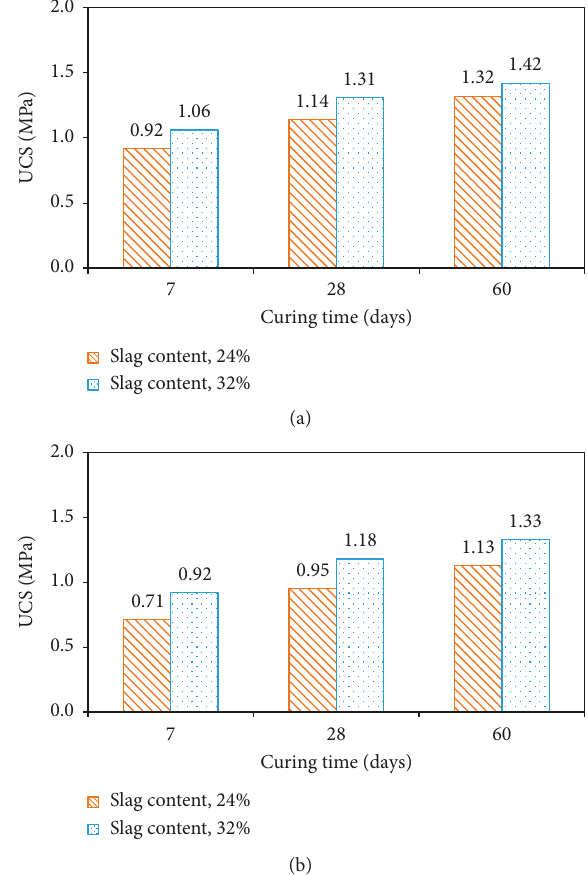
Figure 9: Unconfined compression strength results for LTB. (a) Unconditioned set. (b) Conditioned set.